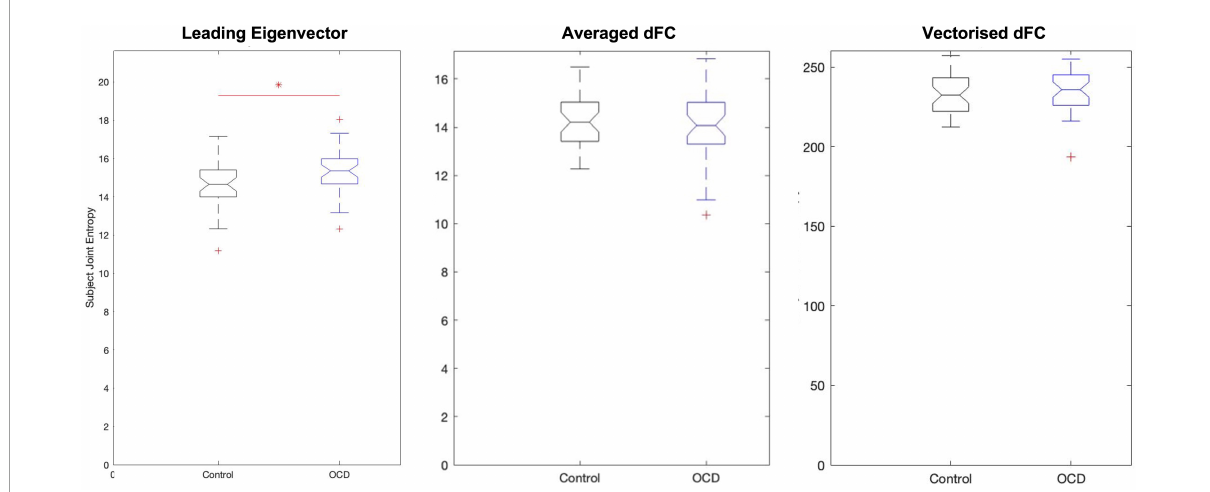
FIGURE3 Analysis of eigenvector-based component time series ( T E ) shows that obsessive-compulsive patients display substantially higher joint entropy than age-, gender-, and education-matched controls. On average, controls display a joint entropy of 14 . 5695 ± 1 . 2473, while patients display a mean joint entropy of 15 . 2214 ± 1 . 1535. Neither spatial average-based components nor vectorized dFC-based components display group-level